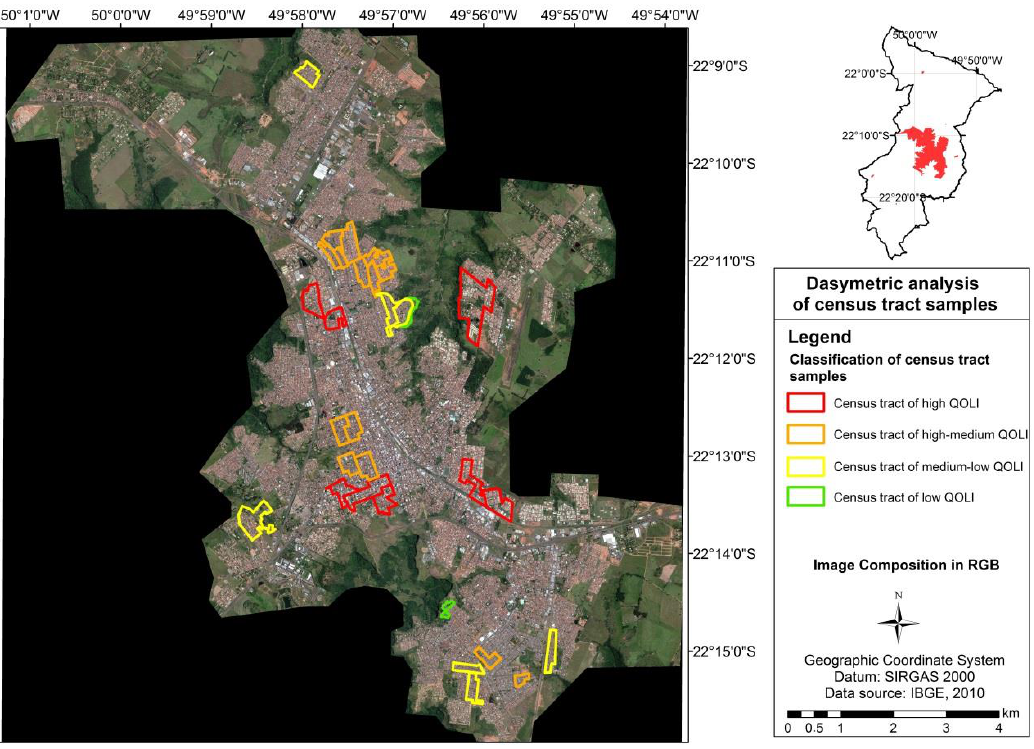
Figure 5. Dasymetric analysis of the census tract samples.